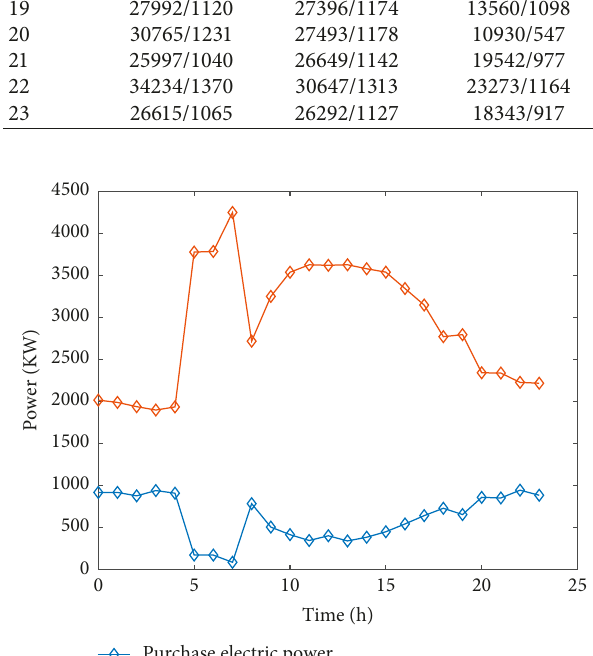
Figure 2: Output of each energy conversion equipment.